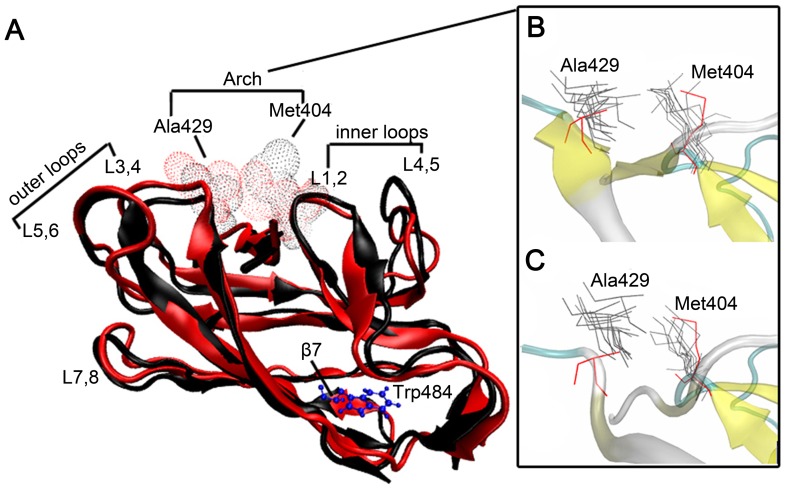
Superimposition of DnaKWT and DnaKL483W structures.(A) Superimposition of the Cα atoms of DnaKL484W (red) and DnaKWT (black) structures at the end of the MD simulation. (B) and (C) show superposition of the arch structure snapshots for DnaKWT and DnaKL484W, respectively.